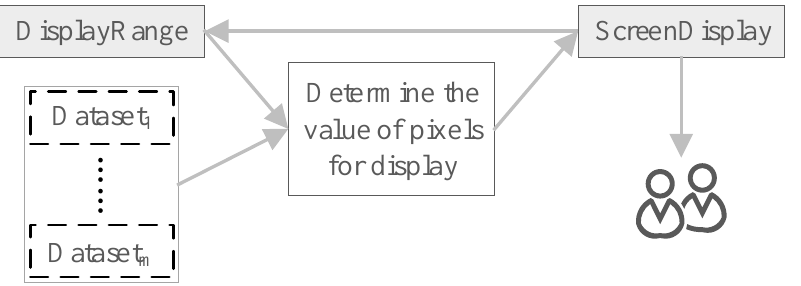
Figure 3. Buffer-overlay analysis flow in